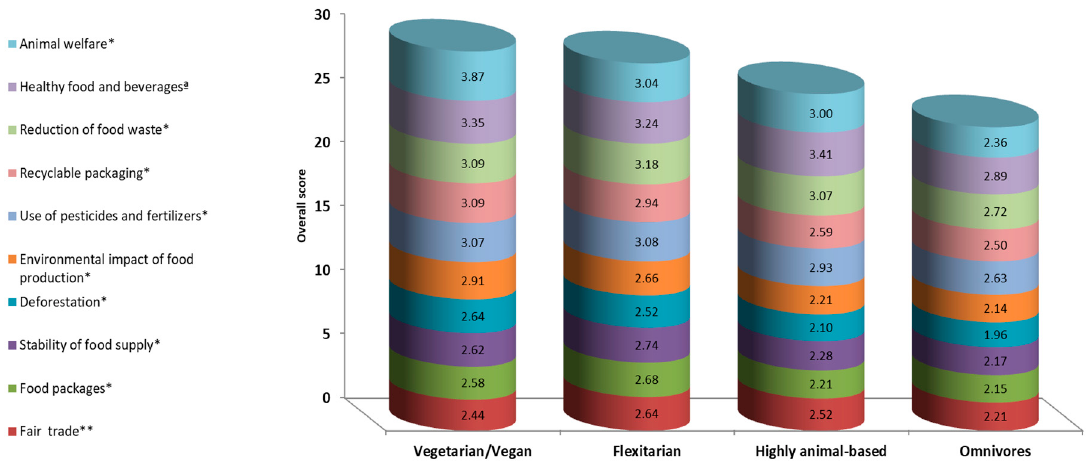
Figure 3. Willingness to act (perceptions of “it’s important that I act”) by eating pattern. Only significant items are shown. Items not included are employment of minors in the food industry, food prices, the quality of public health services, food safety, and energy for storing, cooking, and transporting. * Omnivores significantly differ from vegans and flexitarians. ** Omnivores significantly differ from flexitarians. ª Omnivores significantly differ from participants with all other patterns. All p -values < 0.05, Bonferroni-corrected for multiple comparisons. Table 3. Characterization of participants by eating